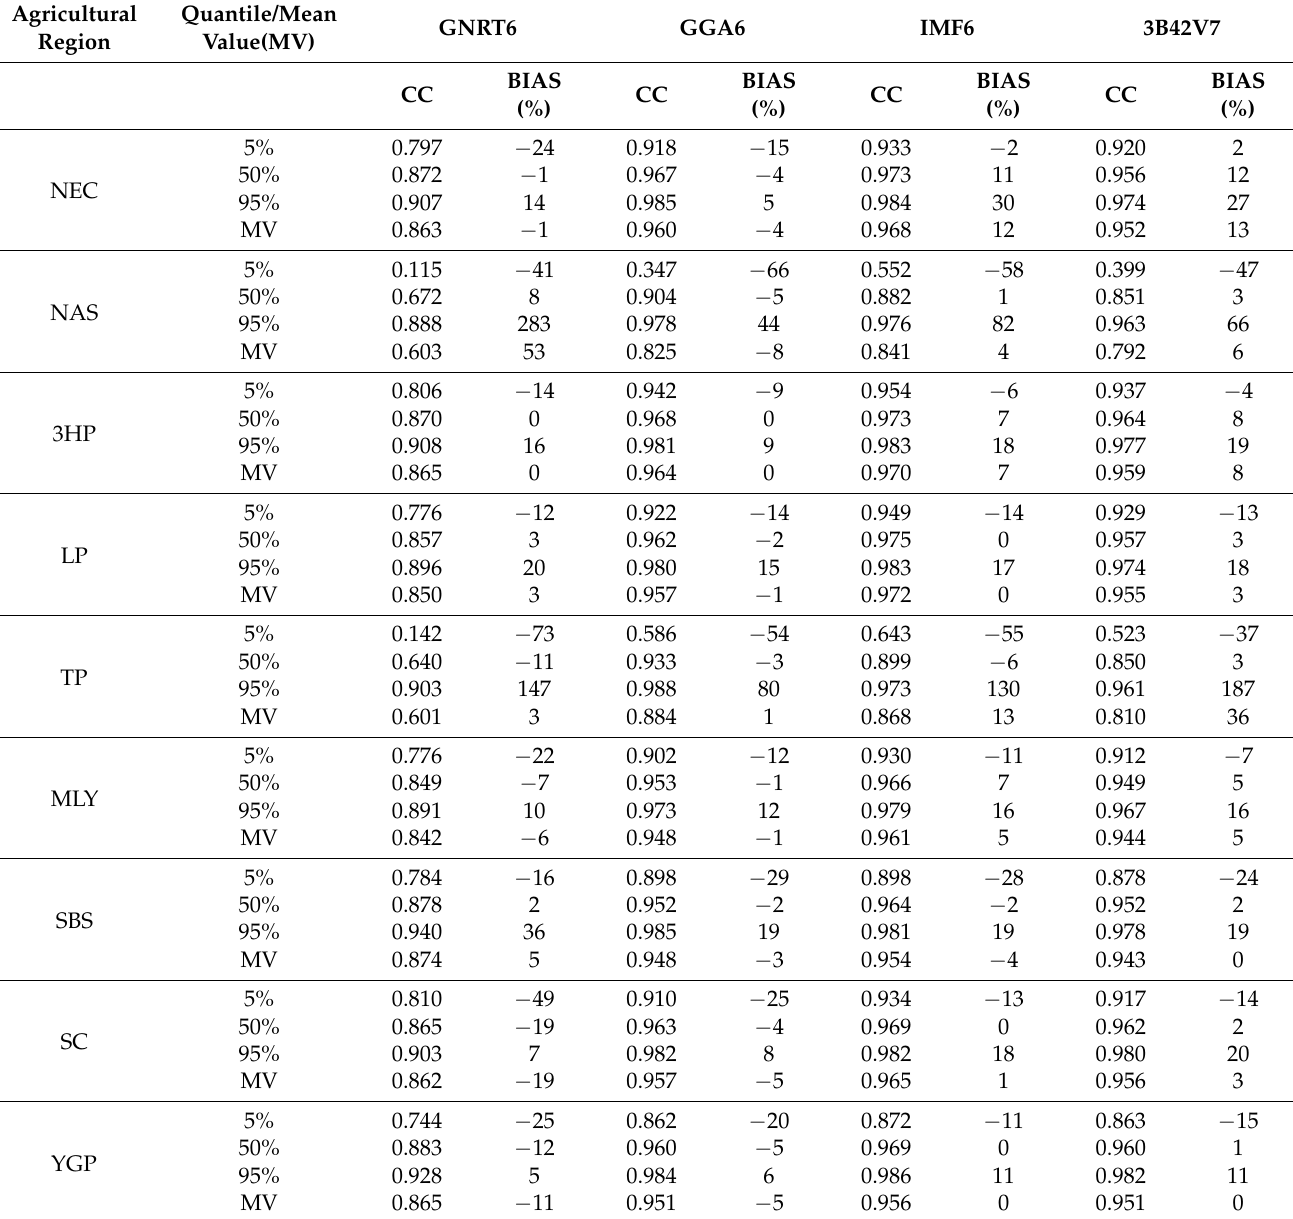
Table 3. 50% and 95% quantiles of monthly CC and BIAS of the four SREs w.r.t. in situ observations for the nine agricultural regions for